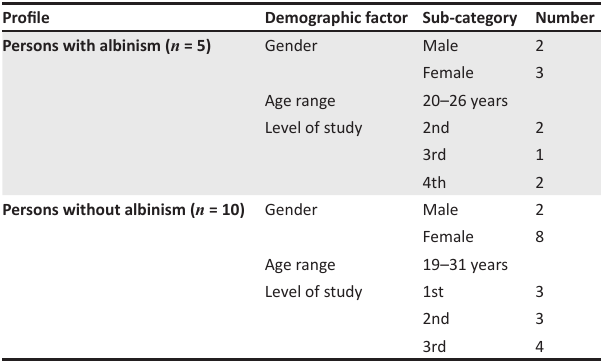
TABLE 1: Profile of participants ( N = 15).